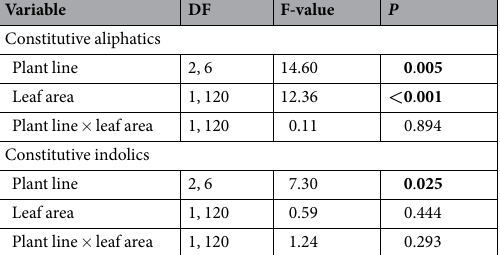
Table 1. Results from general linear mixed models testing for the effects of plant domestication (i.e., plant line), leaf area and their interaction on constitutive levels of aliphatic and indolic glucosinolates in leaves. We used three plant lines, the wild cabbage Brassica oleracea ssp. oleracea and two domesticated varieties of this species ( B . oleracea var. acephala and B . oleracea var. capitata). We included leaf area (the tissue targeted for domestication) to test for a size-defence trade-off. The interaction term tests for different slopes of the relationship between constitutive glucosinolate levels and leaf area among the plant lines. F-values, degrees of freedom (numerator, denominator), and associated significance levels ( P ) are shown. Significant effects ( P < 0.05) are in